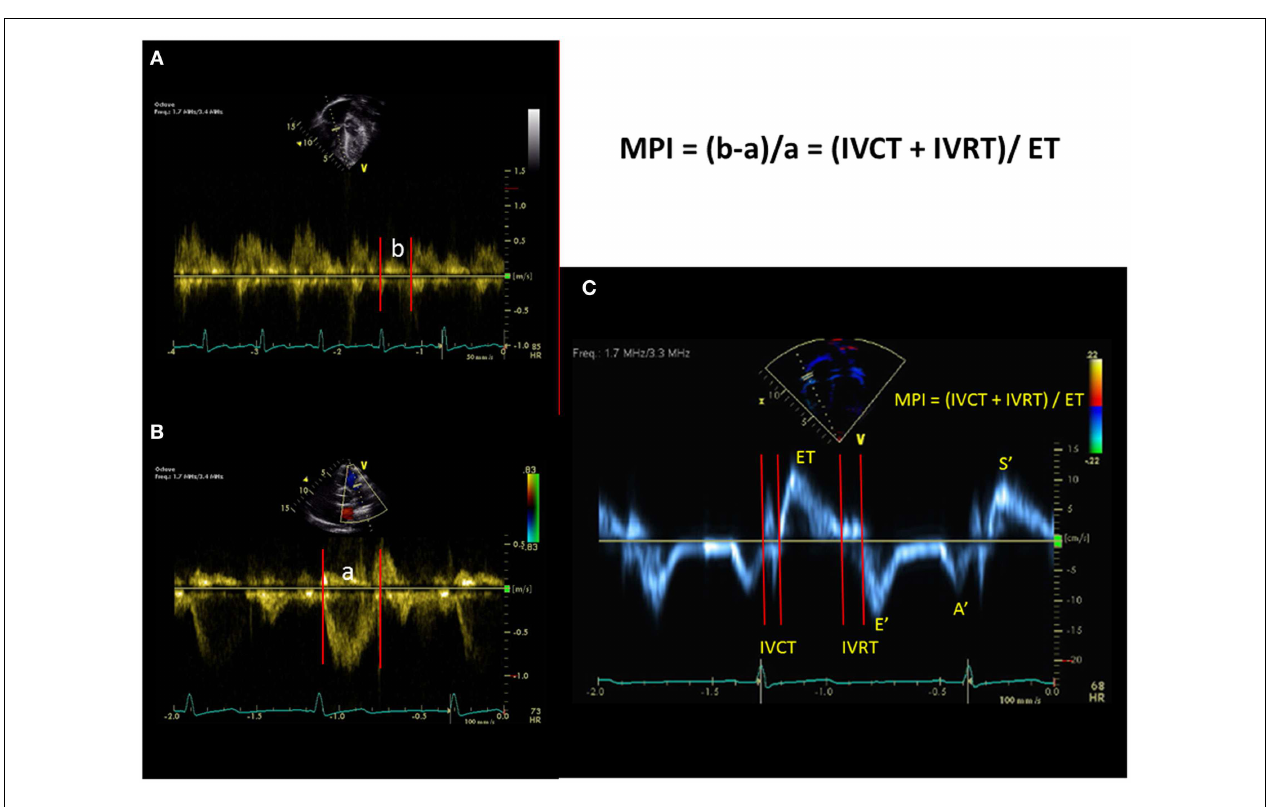
valve . IVCT = isovolumic contraction time, IVRT = isovolumic relation time, and ET = ejection time.Tissue Doppler imaging of the tricuspid valve. S (cid:48) = systolic velocity, E (cid:48) = early diastolic velocity, A (cid:48) = late diastolic